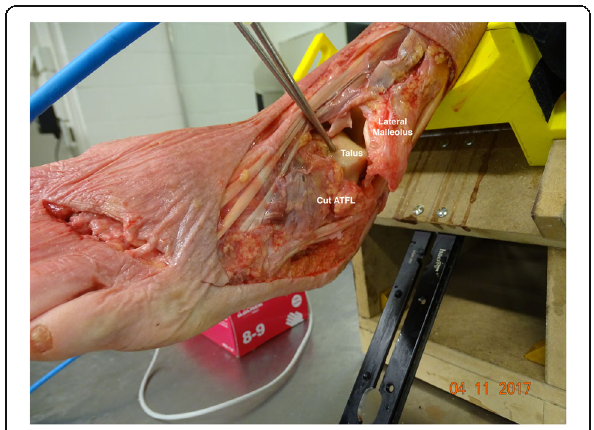
Fig. 5 Cadaver model after ATFL, CFL and PTFL section. The cut ATFL and antero-lateral capsule remnants are visible. There is evident subluxation of the talus relative to the ankle